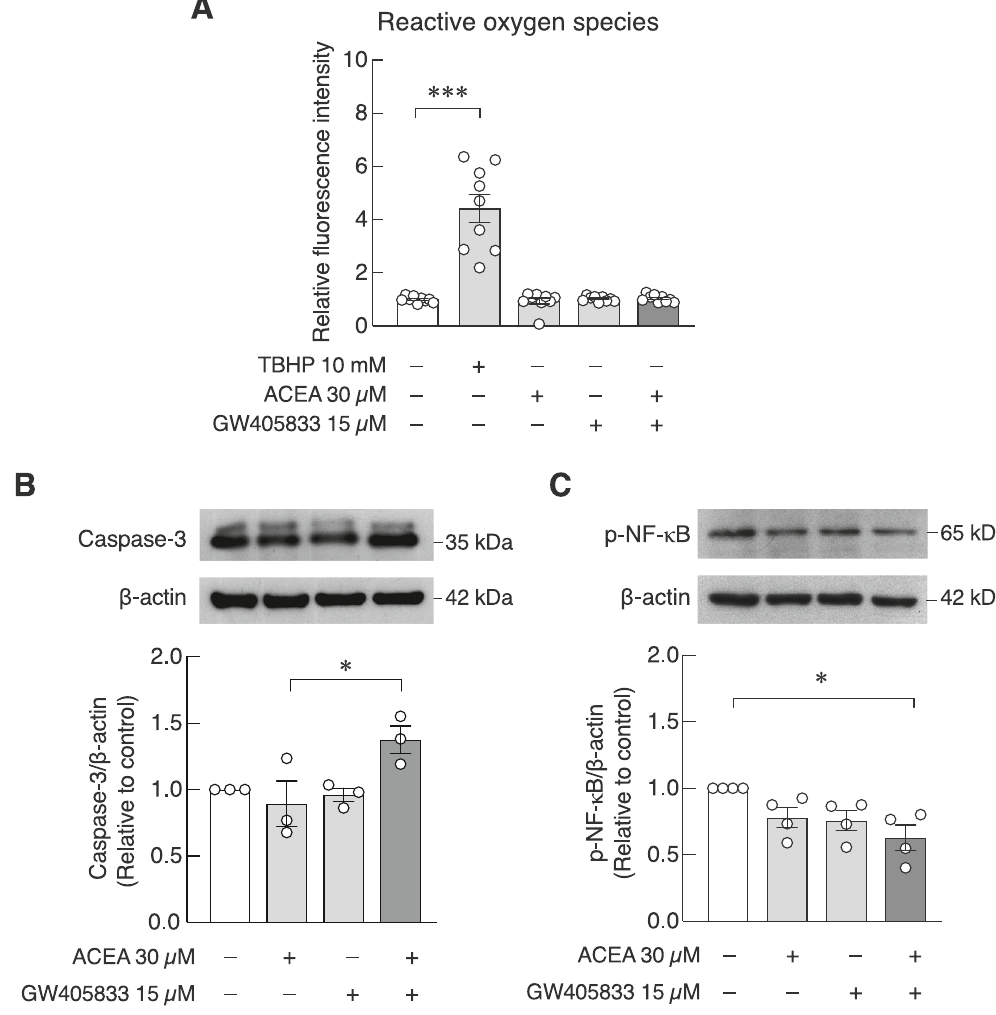
Figure 6. Combination of ACEA and GW405833 did not have effect on ROS but decreased p-NF-κB protein expression and increased Caspase-3 protein expression in MDA-MB-231 cells. ( a ) Cellular ROS in MDA-MB-231 cells treated for 6 h with 30 µM ACEA, 15 µM GW405833, or a combination of both agents was quantified by DCFDA cellular ROS detection assay. As positive control, cells were treated with 10 mM TBHP (tert-butyl hydroperoxide) for 6 h. The expression of ( b ) Caspase-3 and ( c ) p-NF-κB proteins in cells treated for 48 h with ACEA and GW405833 alone or in combination was analyzed by western blot analysis. Columns represent mean ± SEM of three independent biological experiments. (*** p < 0.001, * p <